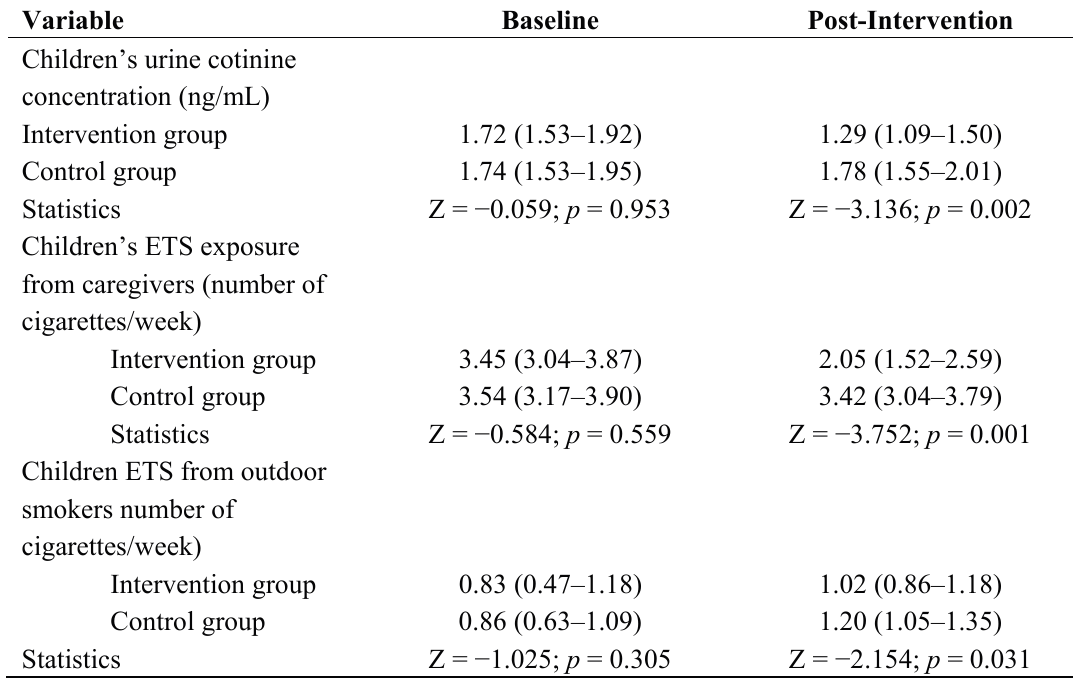
Table 2. Children’s environmental tobacco smoke (ETS) exposure from caregivers and other smokers, and urinary cotinine levels, at baseline and post-intervention (after 6